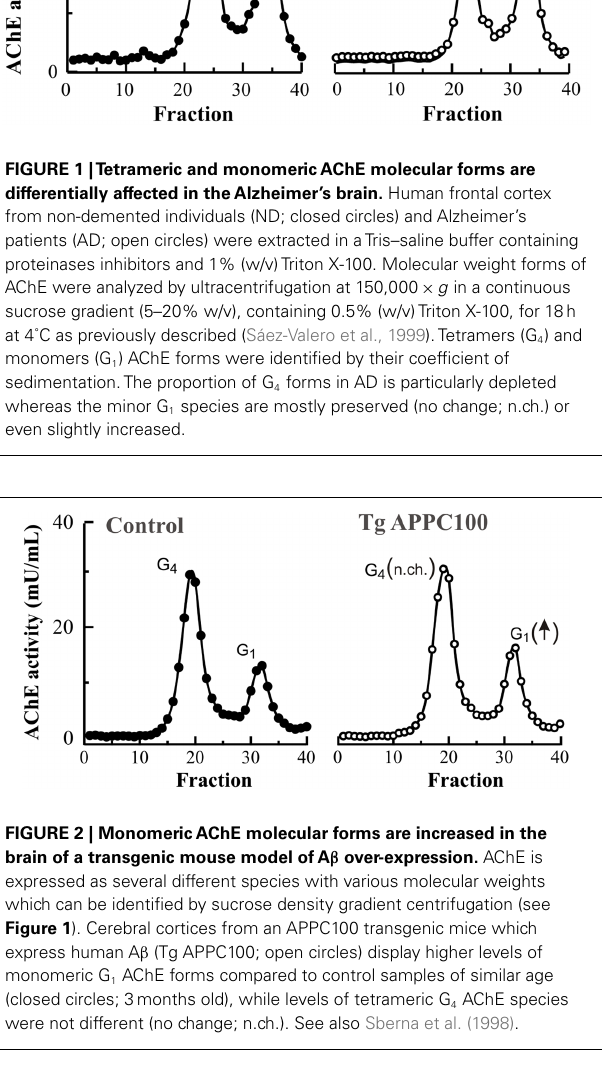
increase in monomeric AChE around plaques and in A β models is